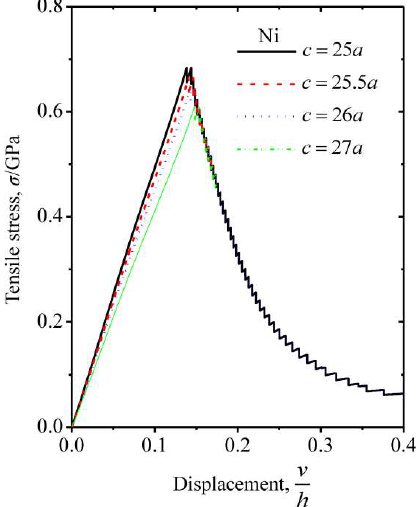
Figure 5. Tensile stress (  ) of Cu nanoplates as a function of v / h for four lengths of edge crack: c = 25 a ,